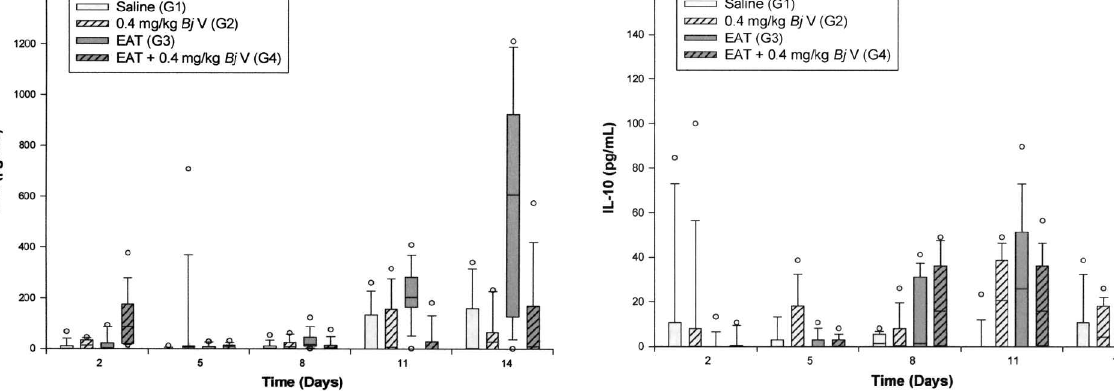
FIG. 2. Box plot of the IL-6 level kinetics in EAT cells treated with Bj V. Each box represents 25–75% values with the median as an internal line, the error bar represents 10% and 90%, and the circle represents the outliers. Statistics: 2nd day, G4 > (G1 = G2 = G3); 5th day, G2 > G1; 11th day, G3 > (G1 = G4); 14th day, G3 > (G1 = G2 = G4); p < 0.05.